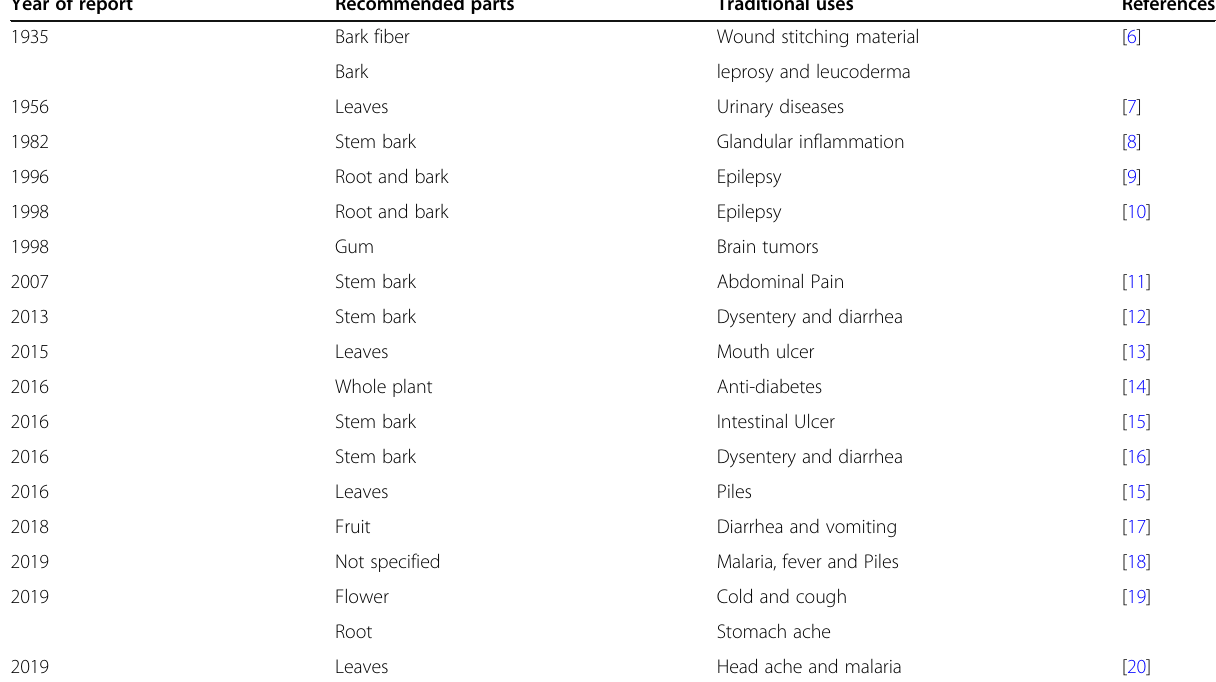
Table 1 Traditional uses of B . racemosa Year of report Recommended